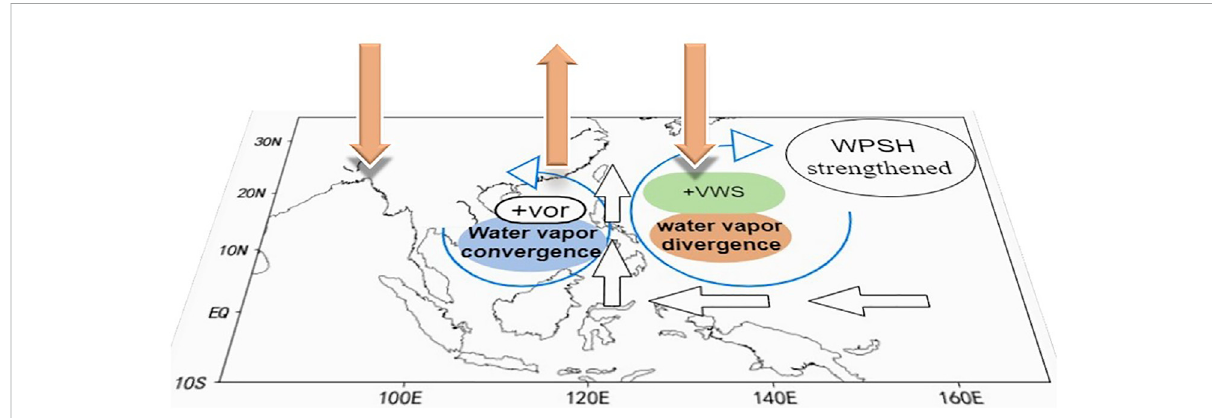
level anomalous cyclonic circulation and low-level convergence. At the